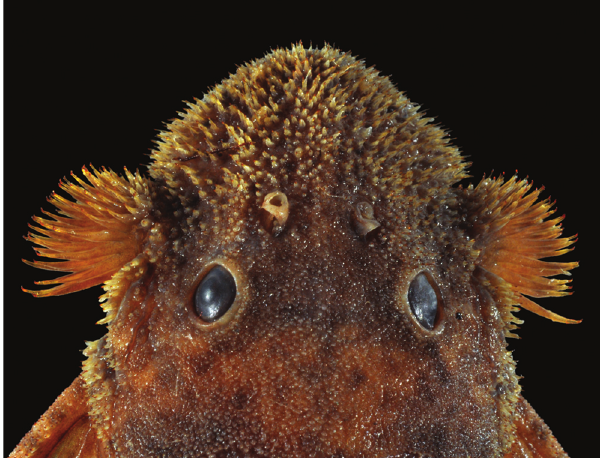
Fig. 3. Dorsal view of head of holotype of Neblinichthys peniculatus , MBUCV V-35680, 78.8 mm